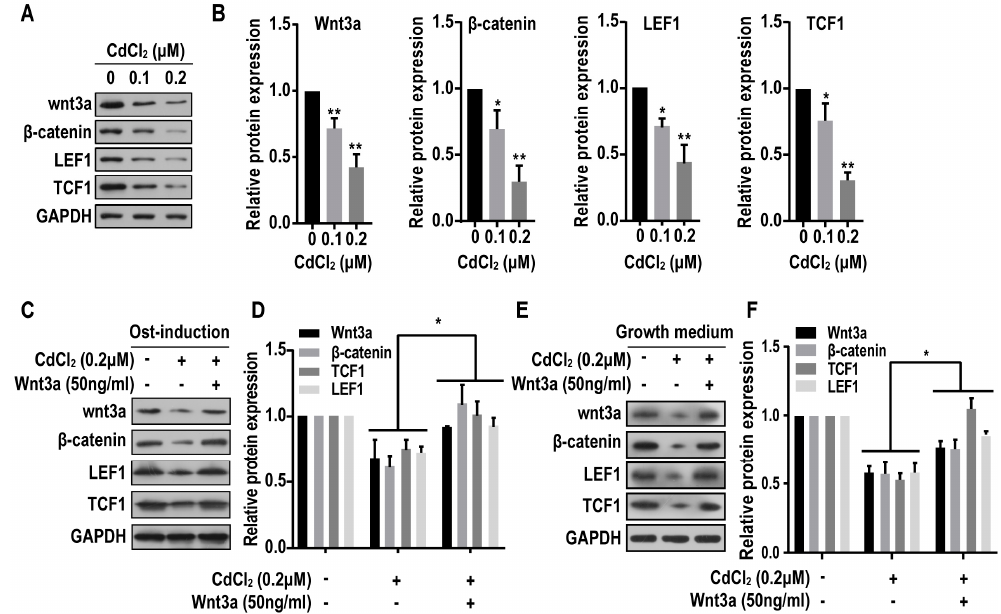
Figure 5. The effects of cadmium on Wnt/ β -catenin pathway. BMMSCs were exposed to 0, 0.1 or 0.2 µM CdCl 2 for 24 h. ( A ) Western blots were performed, and ( B ) relative protein levels of Wnt3a, β -catenin, LEF1 and TCF1 were determined (mean ± SD, n = 3). * p < 0.05, ** p < 0.01, different from control BMMSCs. BMMSCs were exposed to 0, 0.2 µM CdCl 2, or 50 ng/mL Wnt3a with the treatment of 0.2 µM CdCl 2 in osteogenic medium for 24 h. ( C ) Western blots were performed, and ( D ) relative protein levels of Wnt3a, β -catenin, LEF1 and TCF1 were determined (mean ± SD, n = 3). * p < 0.05, different from BMMSCs treated with CdCl 2 . BMMSCs were exposed to 0, 0.2 µM CdCl 2 , or 50 ng/mL Wnt3a with the treatment of 0.2 µM CdCl 2 in growth medium for 24 h. ( E ) Western blots were performed, and ( F ) relative protein levels of Wnt3a, β -catenin, LEF1 and TCF1 were determined (mean ± SD, n = 3). * p < 0.05, different from BMMSCs treated with CdCl 2 .